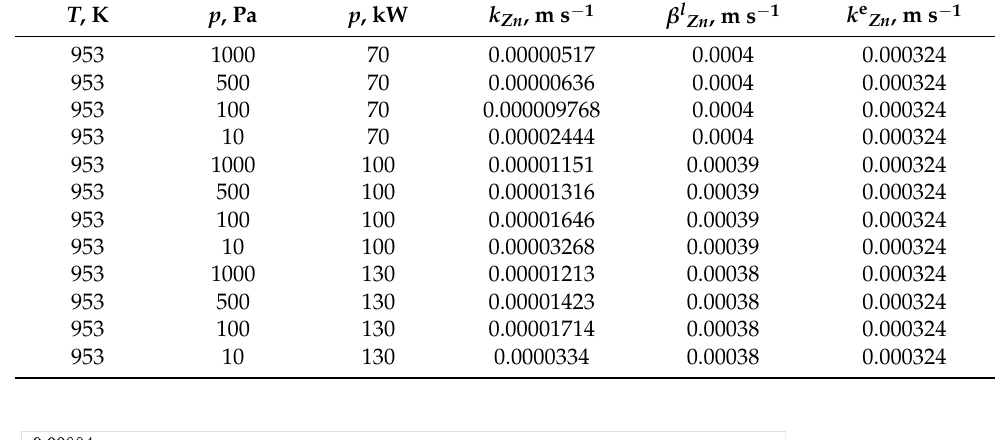
Table 6. The overall mass transfer coefficient k Zn and the coefficients β l Zn and k e Zn (induction furnace with a cold crucible).